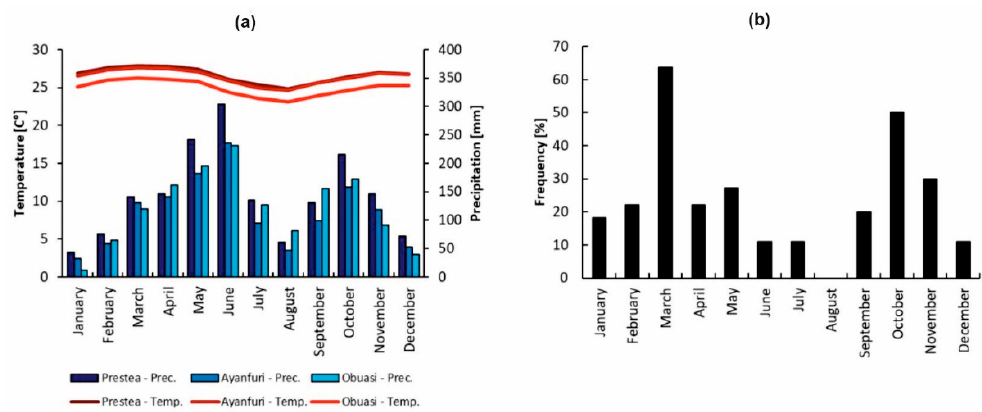
Figure 12. Comparison of climate records and summary statistics of Sentinel-1 time series images affected by atmospheric effects (2015–2019): ( a ) monthly average temperature and precipitation at stations Prestea, Ayanfuri, and Obuasi (Source: climate-data.org) and ( b ) frequency of S-1 scenes showing a strong local decrease in the backscatter intensity due to clouds, shown as a percentage of all available scenes per month.